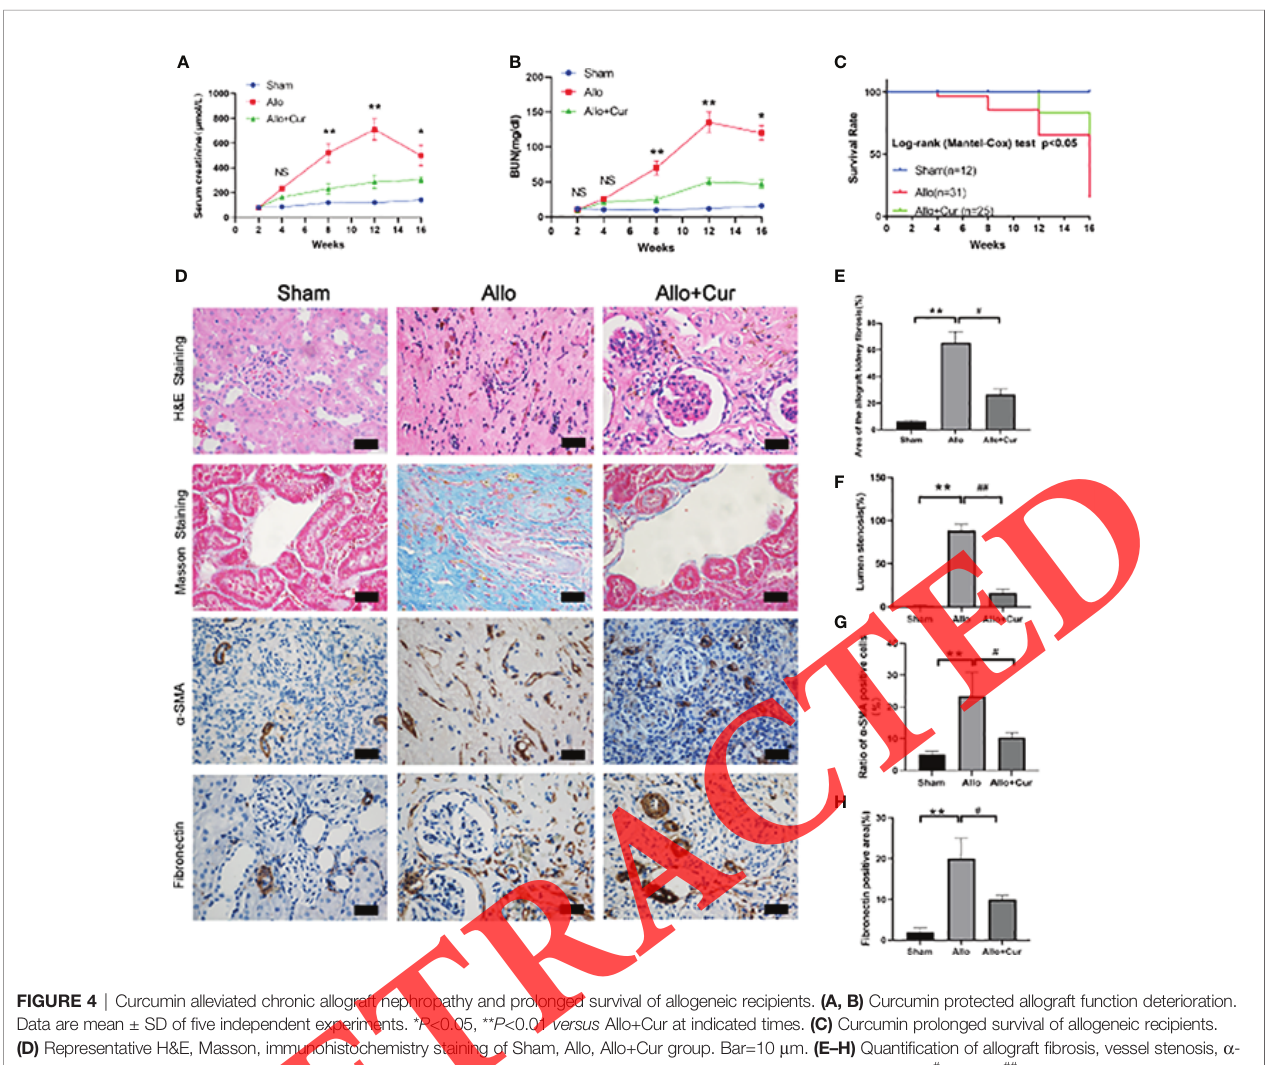
FIGURE 4 | Curcumin alleviated chronic allograft nephropathy and prolonged survival of allogeneic recipients. (A, B) Curcumin protected allograft function deterioration. Data are mean ± SD of fi ve independent experiments. * P <0.05, ** P <0.01 versus Allo+Cur at indicated times. (C) Curcumin prolonged survival of allogeneic recipients. (D) Representative H&E, Masson, immunohistochemistry staining of Sham, Allo, Allo+Cur group. Bar=10 m m. (E – H) Quanti fi cation of allograft fi brosis, vessel stenosis, a - SMA positive cells and FN positive area. Data are mean ± SD of fi ve independent experiments. ** P <0.01 versus Sham group. # P <0.05, ## P <0.01 versus Allo group. NS, not signi fi